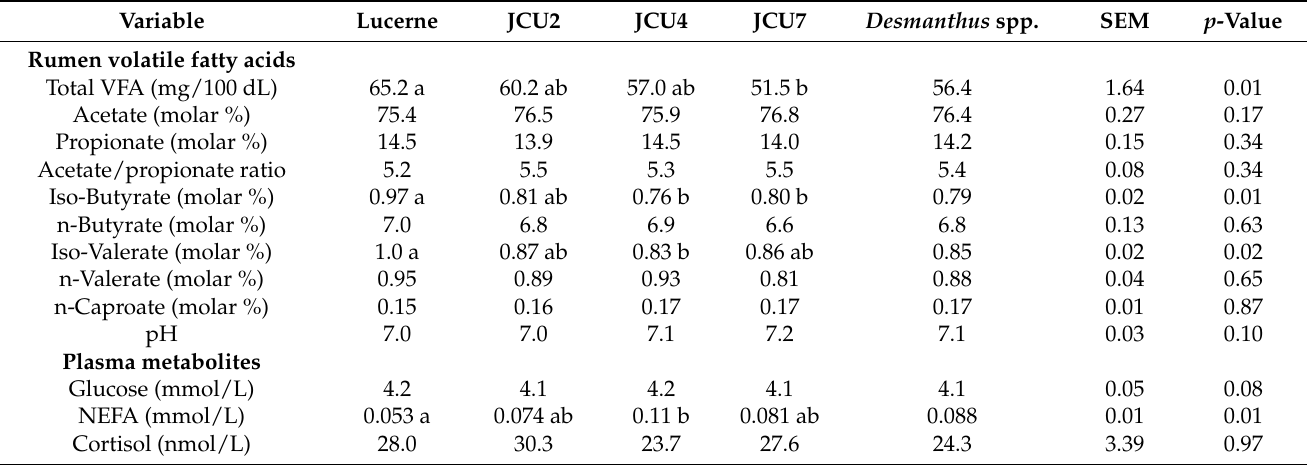
Table 5. Rumen VFA and plasma metabolites of steers fed lucerne and Desmanthus spp.